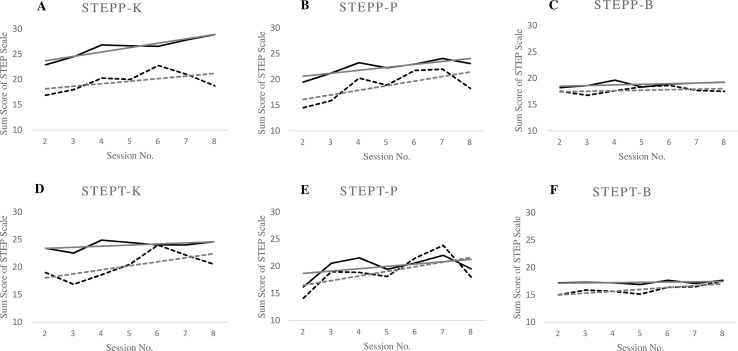
Changes in the sum scores of each “Stundenbogen für die Allgemeine und Differentielle Einzel-Psychotherapie” (STEP) scale in relation to therapeutic session number. Graphs (A) and (B) show main effects of change across time (number of therapeutic sessions) and Beck Depression Inventory (BDI) improvement. Graph (D) shows main effects of change across time (number of therapeutic sessions) and graph (E) shows main effect of BDI improvement. Graphs (C) and (F) show no significant effects of change across time (number of thrapeutic sessions) of patient and therapist between the word improvement. STEPP-K, patient, scale motivational clarifications; STEPP-P, patient, scale active assistance in problem solving; STEPP-B, patient, scale therapeutic relationship; STEPT-K, therapist, scale motivational clarification; STEPT-P, therapist, scale active assistance in problem solving; STEPT-B, therapist, scale therapeutic relationship, session number. Solid lines: group with improvement in BDI sum score ≥9 points; broken lines: group with improvement in BDI sum score ≤8 points; grey lines depict regression lines.